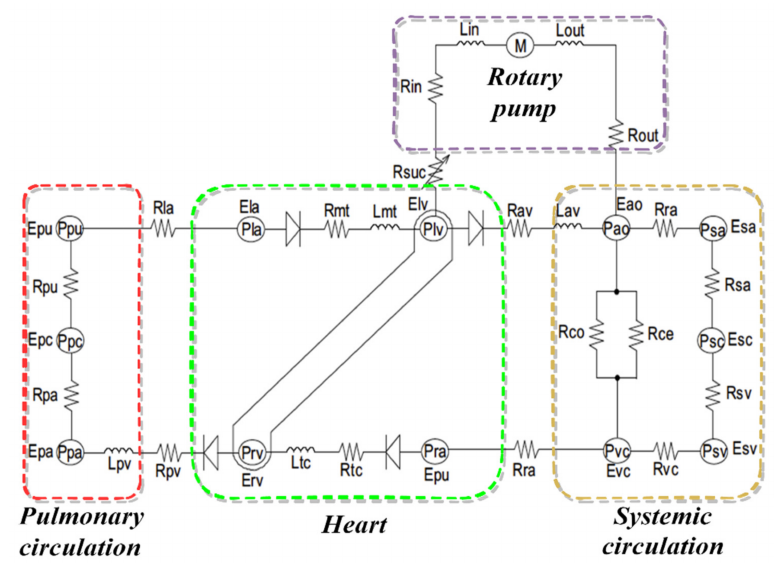
Figure 3. Electrical equivalent circuit analogue of CVS–LVAD interaction. R in : inlet cannula resis- tances; R out : outlet cannula resistances; L in : inlet cannula inertances; L out : outlet cannula inertances; R suc : suction resistance; and P thor 1 and P thor 2 : intrathoracic